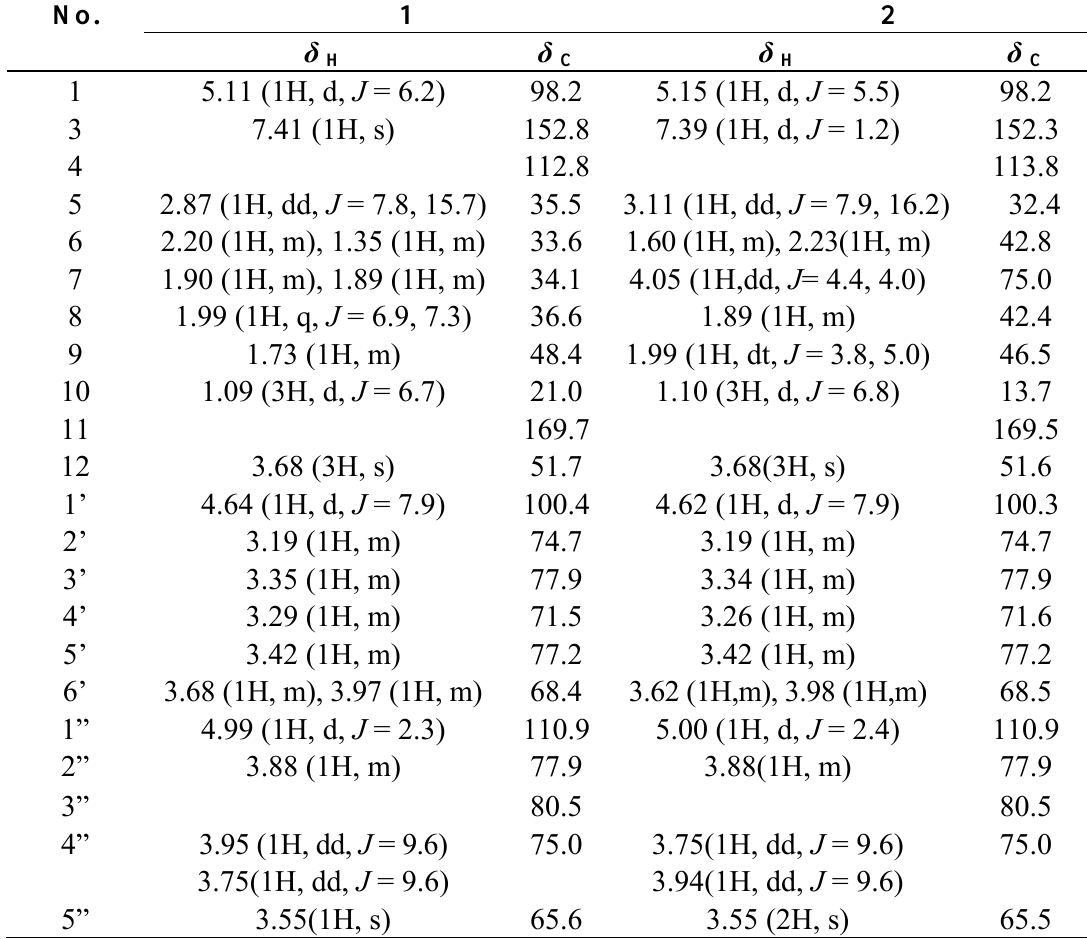
OD at 400 MHz and 100 MHz, J in 3